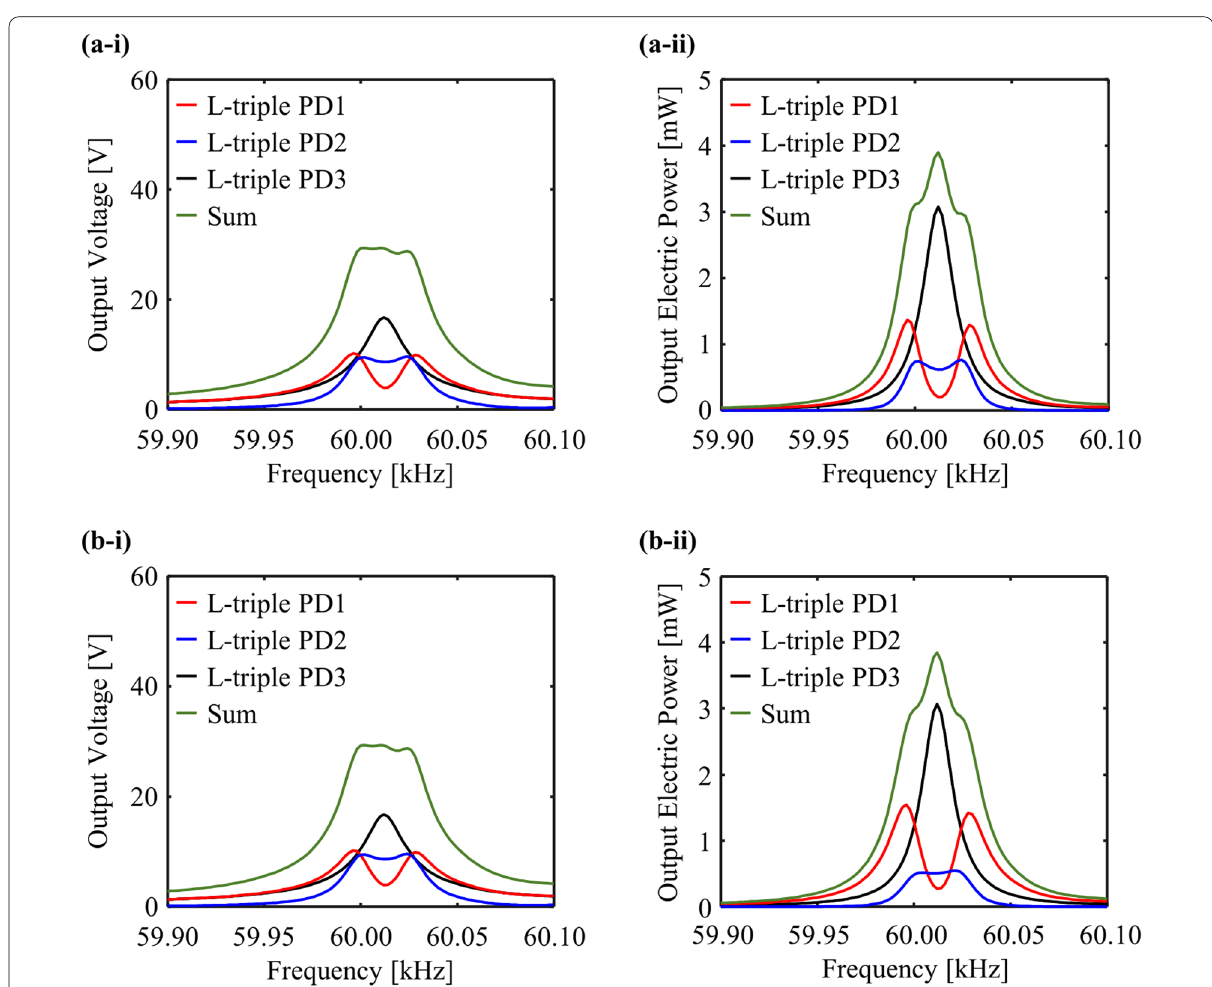
Fig. 5 PEH performance results across the power‑optimal electrical resistances in time‑harmonic analysis: a ‑ i output voltage FRFs and a ‑ ii output electric power FRFs in Case I, b ‑ i output voltage FRFs and b ‑ ii output electric power FRFs in Case